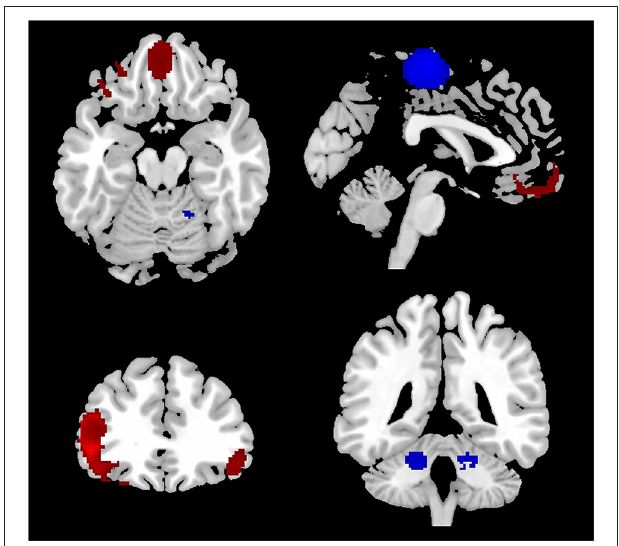
FIGURE 2 | Results of the meta-analysis of whole-brain ReHo studies in patients with OCD. Regions of ReHo alterations in patients with OCD relative to HCS were shown on the three-dimensional T1-weighted template images from software (MRIcroN). Higher ReHo was shown in red color while lower ReHo was displayed in blue color. HCS, healthy control subjects; OCD, obsessive-compulsive disorder; ReHo, regional